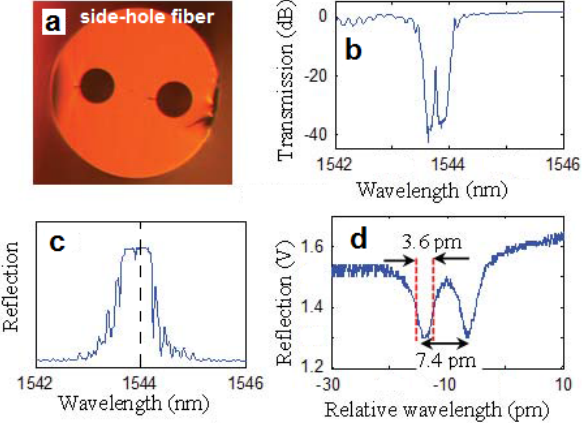
Figure 7. Fiber-optic pressure sensor based on a π-phase-shifted fiber Bragg grating (πFBG) fabricated on a side-hole fiber [65]. ( a ) Section of the side-hole fiber; ( b ) Transmission versus wavelength; ( c ) and ( d ) Reflection versus wavelength of a πFBG fabricated on the side-hole